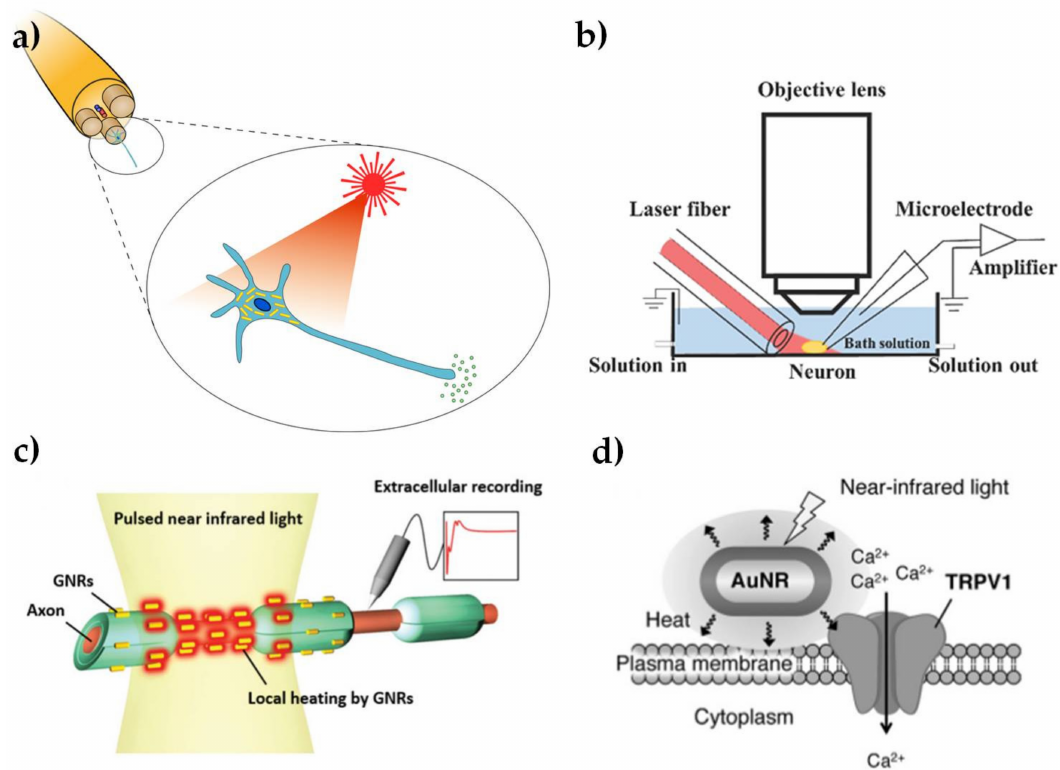
Figure 3. Summary illustration of Au NPs for modulation of nerve electrical activity. ( a ) Schematic representation of laser-induced activation of cells incubated with Au NPs (reproduced with permission from [73]); ( b ) Schematic representation of a whole-cell patch clamp recording for optically-stimulated neurons (reproduced with permission from [10]); ( c ) Schematic representation of optically-stimulated rat sciatic nerves injected with Au NRs (reproduced with permission from [11]); ( d ) Schematic representation of localized heating of TRPV1 channels with NIR excitation of Au NRs (reproduced with permission from